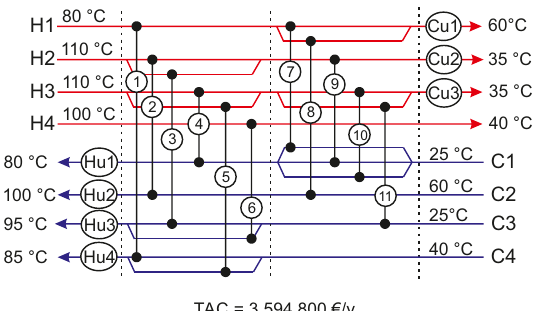
Figure 6. HEN obtained without HP and ST options case 3.